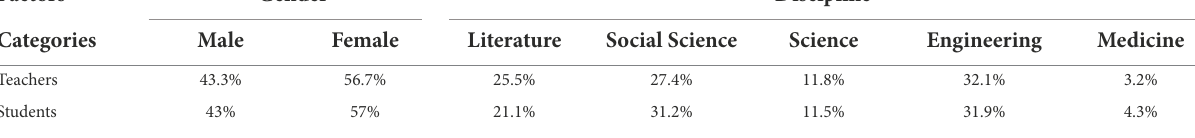
TABLE 1 Socio-demographic characteristics of the